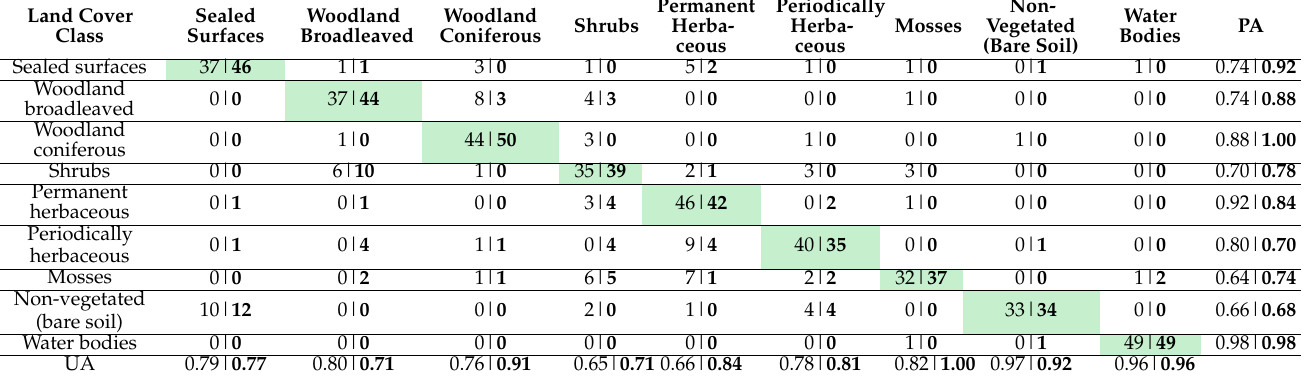
Table 6. Confusion matrix for the flat| hierarchical classification as the result of the independent verification of the land cover maps using the random sampling method. In total, 450 sampling plots (50 plots per class) were distributed over the entire study area and verified; PA = producer’s accuracy and UA = user’s